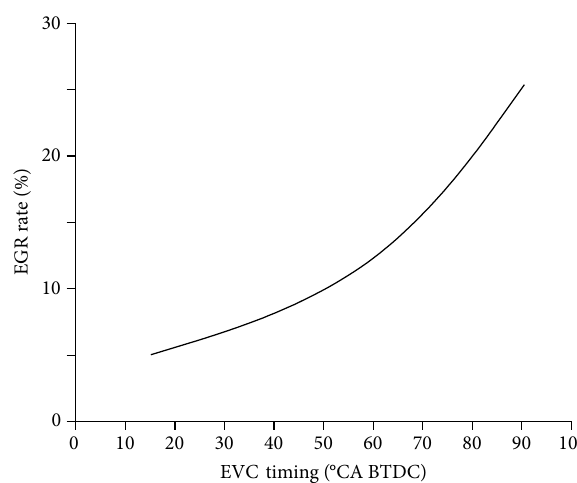
Figure 7: In fl uence of advanced EVC on